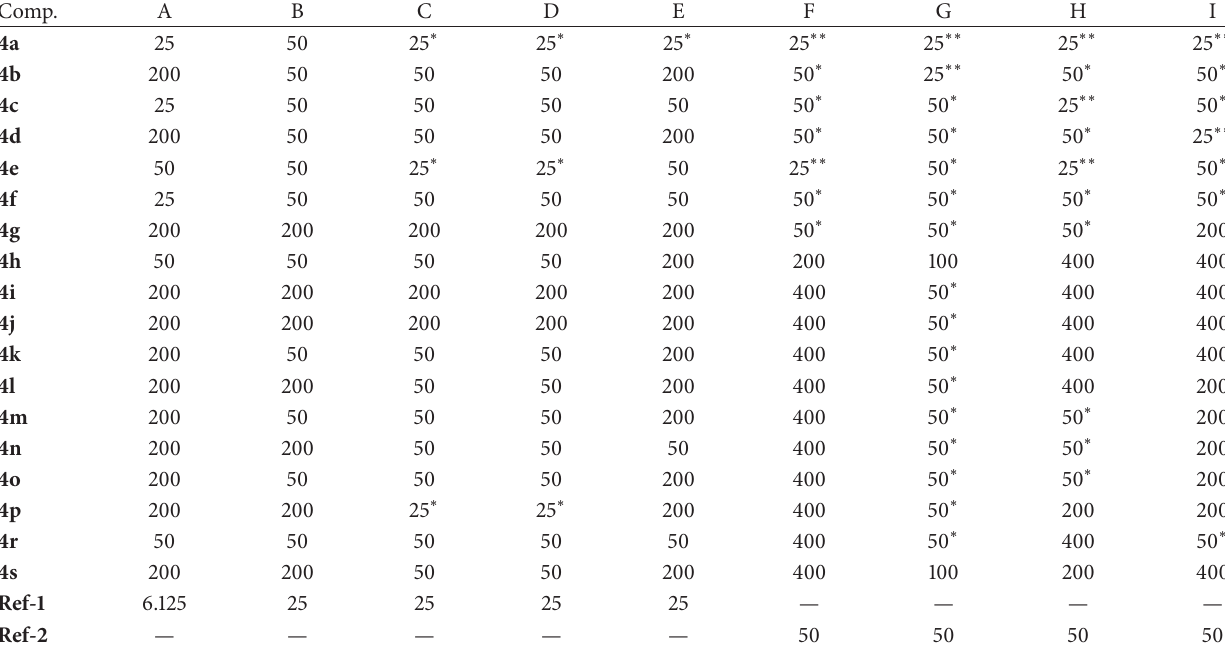
Table 3: Antimicrobial activities of the compounds as MIC values ( 𝜇 g/mL).